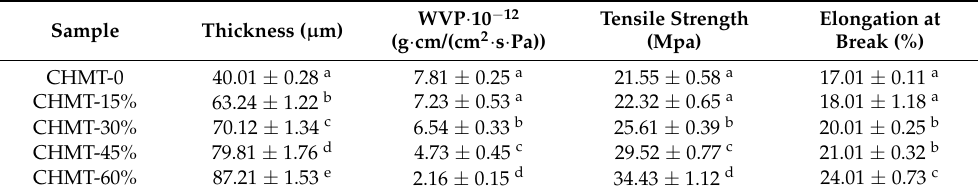
Table 4. Thickness, water vapor transmission coefficient, and mechanical properties of the double- layer antibacterial chromogenic materials.